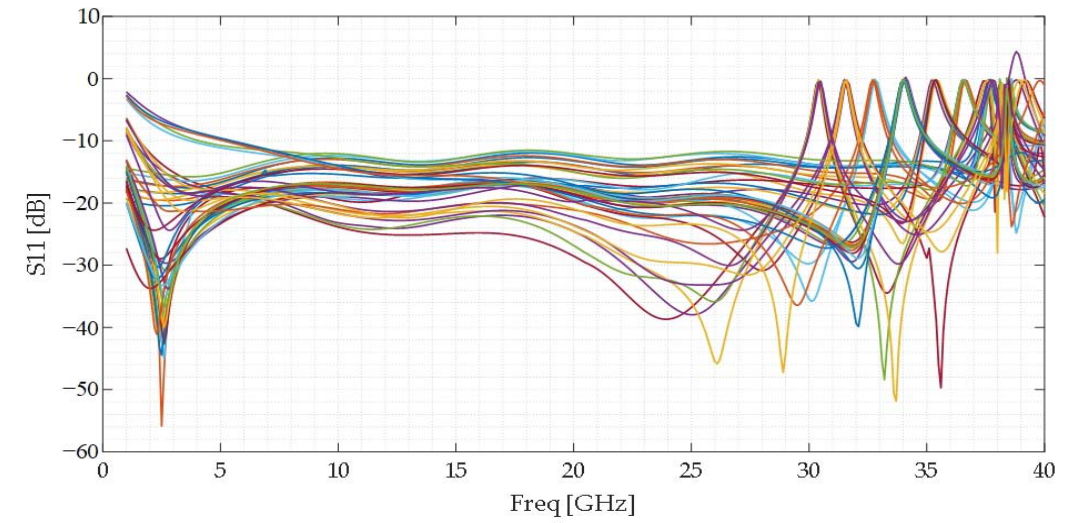
Figure 12. Trend of S 1 1 with frequency under different structural parameters.